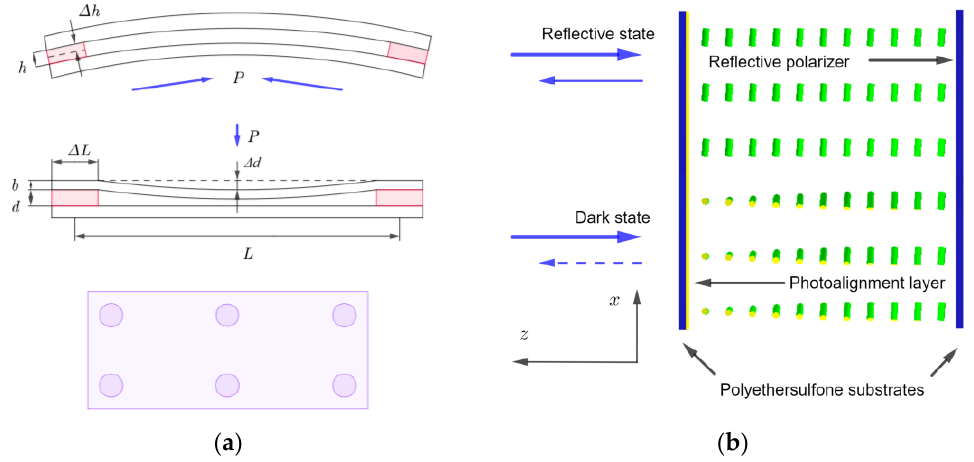
Figure 1. Color online. Structure of flexible e-paper spacers: ( a ) lateral and top views; ( b ) layered structure of ORW e-paper. The scaling is not preserved.